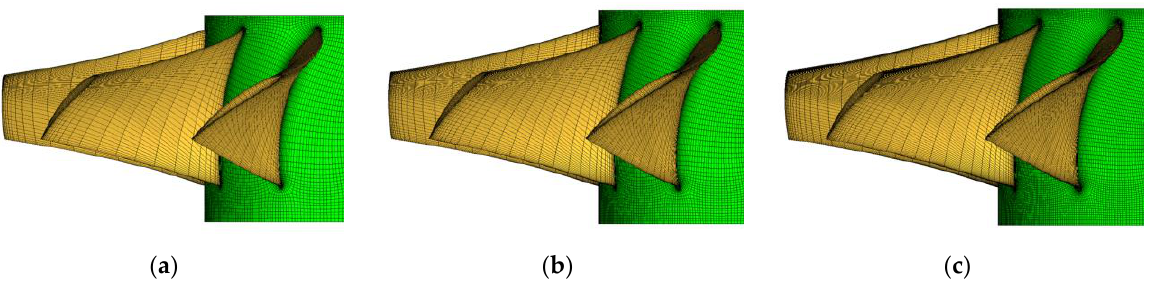
Figure 4. Diagram of rotor grids with different grid sizes: ( a ) 1.18 million, ( b ) 1.92 million, ( c ) 3.11 million.